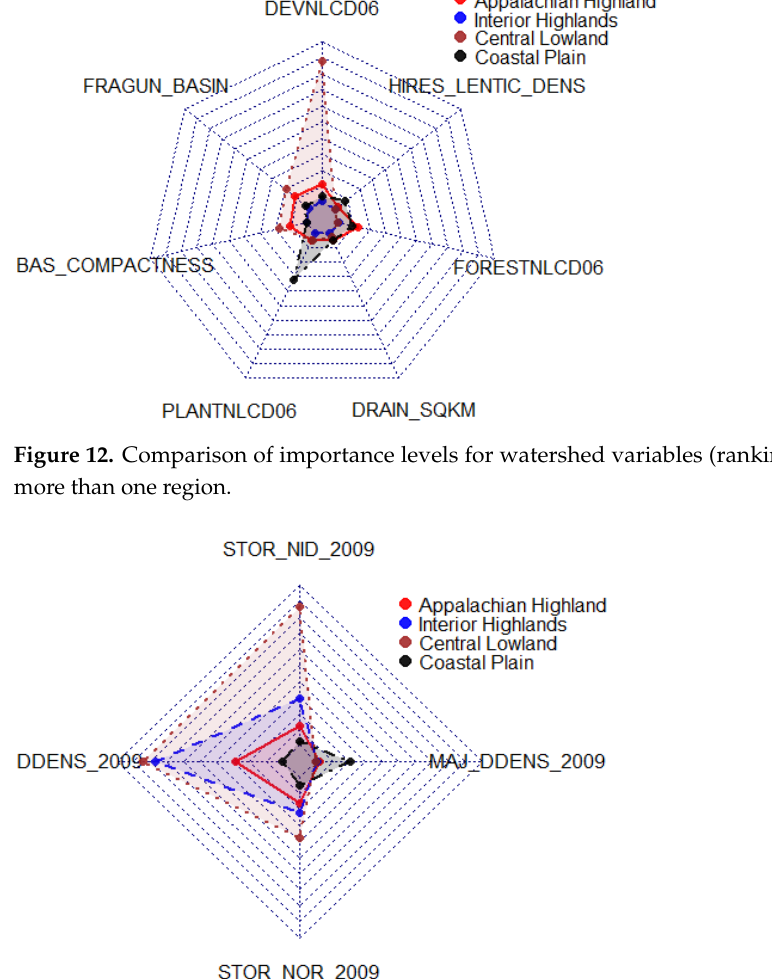
Figure 11. Comparison of importance levels for topography variables (ranking 1 to 10) common to more than one region.